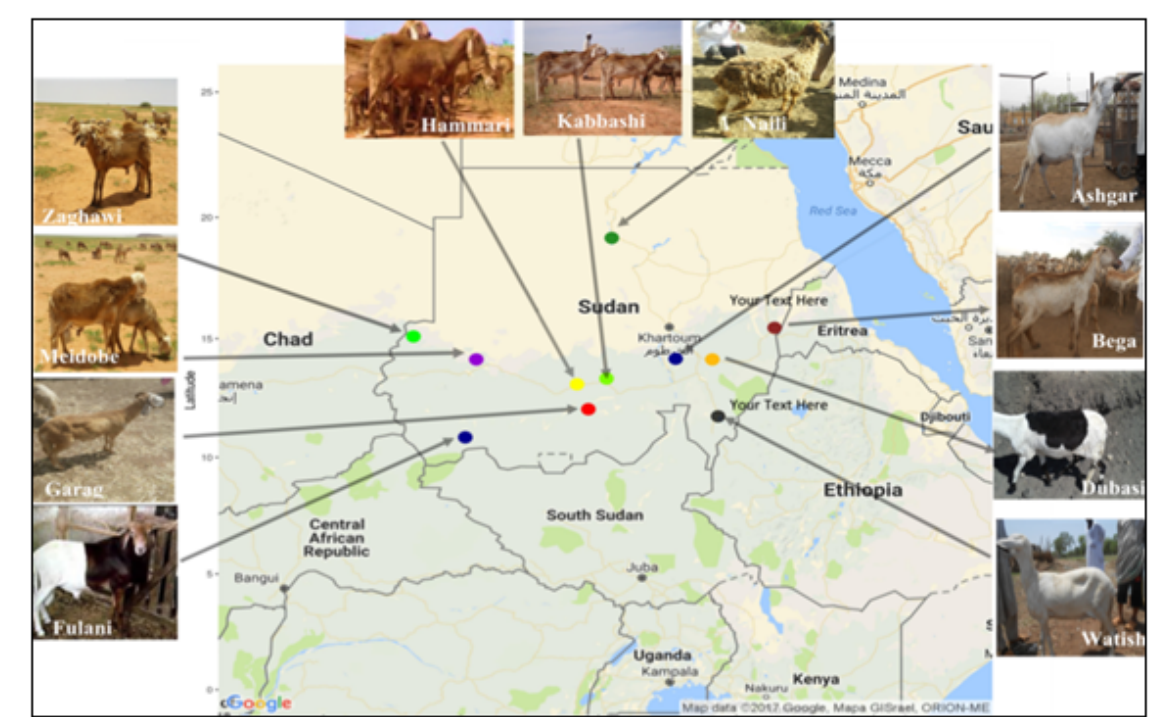
Figure 1. Sheep populations and their geographical distributions. The different colored circles represent the sampling areas for the sheep populations.